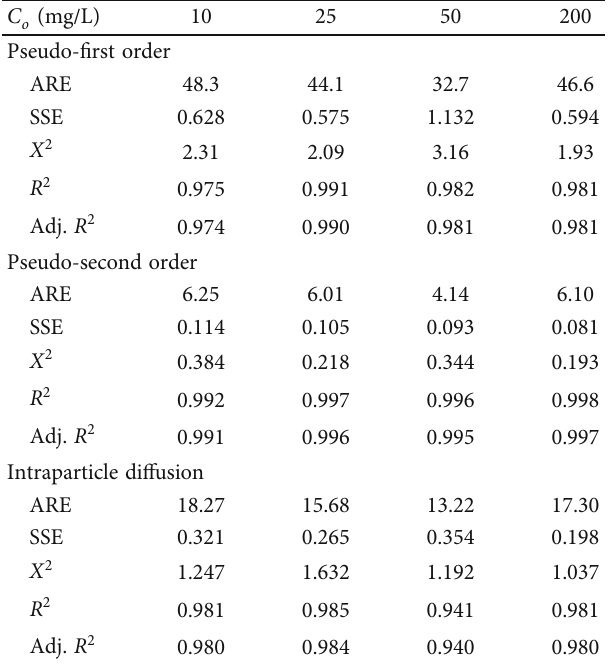
Figure 9: Sorption kinetics of Pb (II) onto MBS and nonlinear fi ts of pseudo- fi rst-order, pseudo-second-order, and intraparticle di ff usion models ( T = 35 ° C, m = 10 g/L). Table 7: Error analysis of kinetic adsorption parameters.